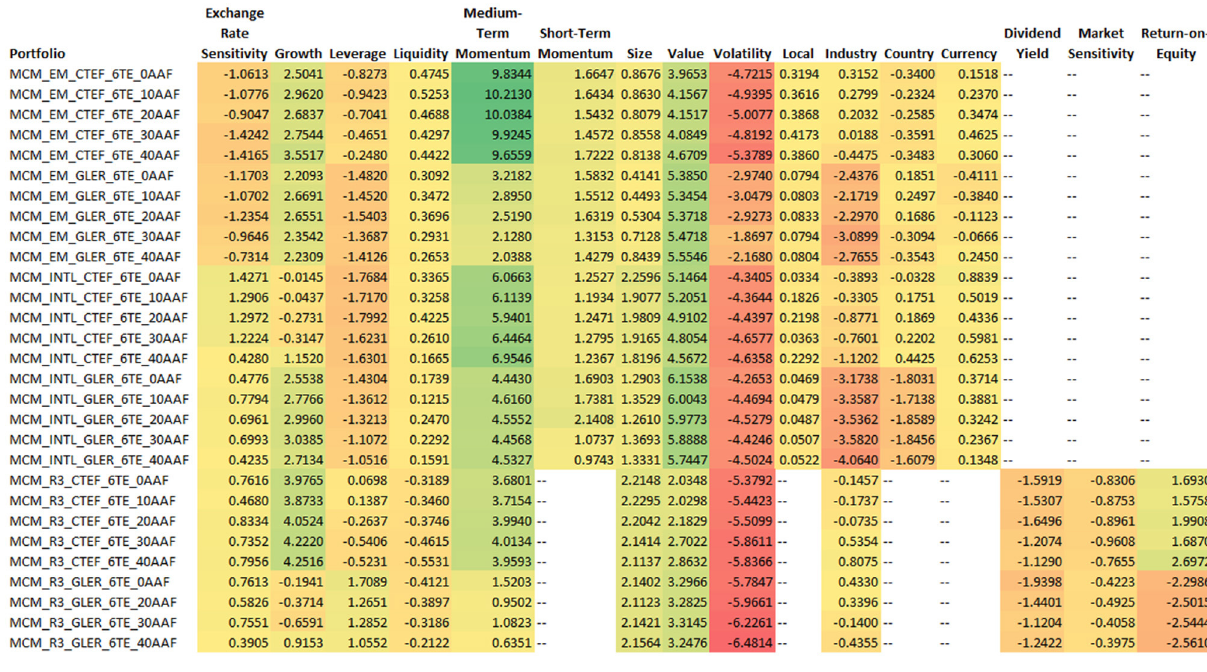
FIGURE 4 | Ex-post factor